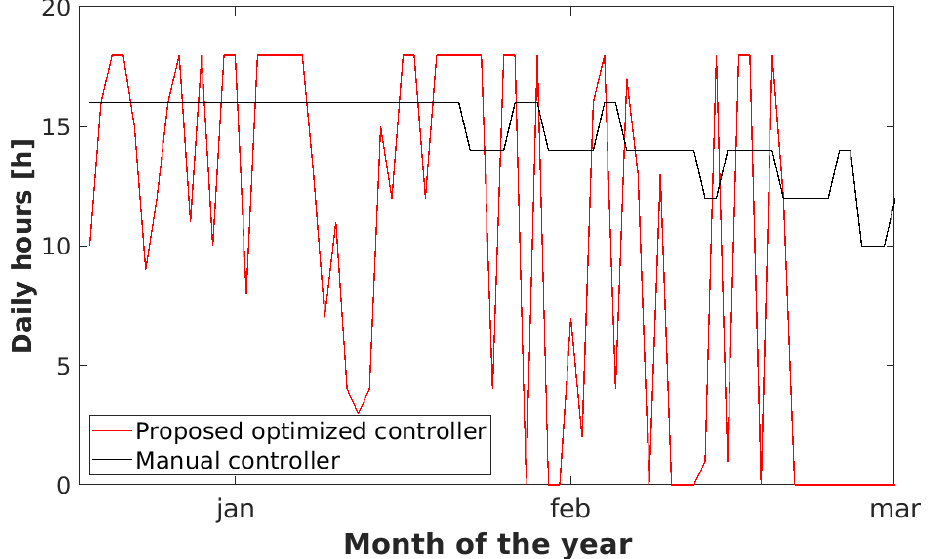
Figure 10. The daily number of hours of artificial lighting system switched on. The black line indicates the existing state-of-the-art controller, while the red line is the control sequence defined and implemented by the proposed